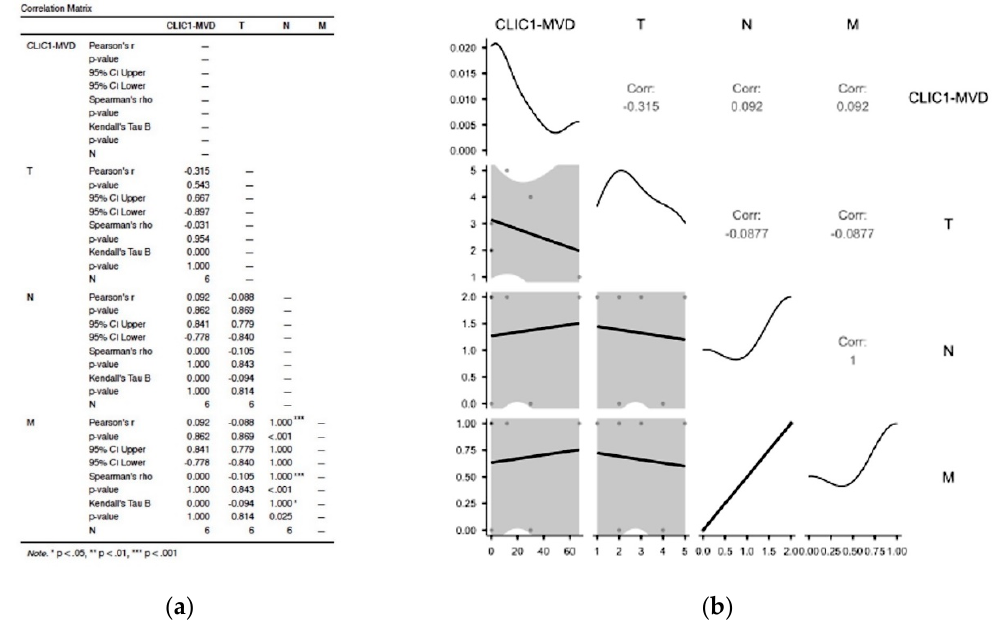
Figure 1. Statistical analysis results ( a ) and correlation plot ( b ) for Class 0 cases related to the TNM staging parameters. No significant correlation was recorded between CLIC1-MVD and T, N, or M parameters. A strong significant correlation has been observed between the N and M parameters, suggesting that CLIC1-MVD may favor nodal and distant metastasis.